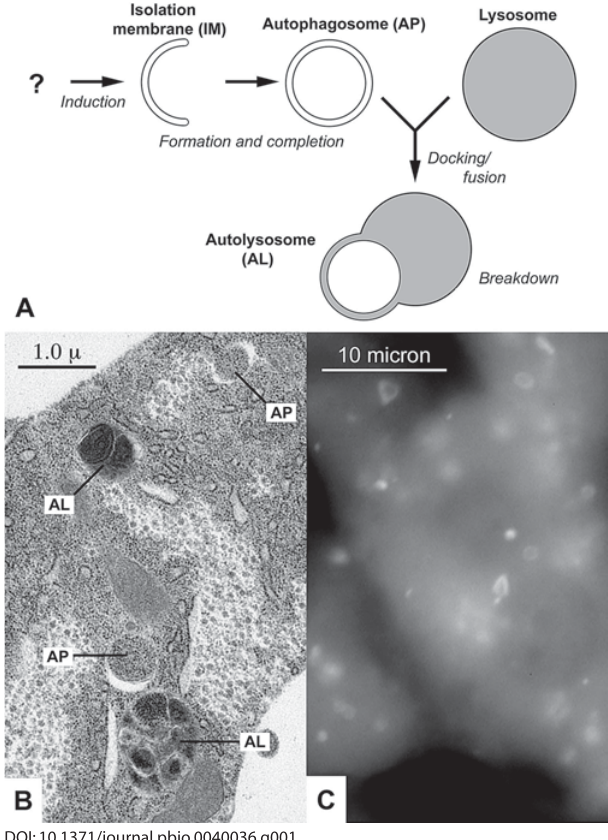
Figure 1. The Dynamic Membrane Events Involved in Autophagy (A) Upon induction of autophagy, a membrane sac called the isolation membrane (IM) forms and engulfs portions of the cytoplasm. Sealing of its edges gives rise to the double-membrane bound autophagosome. Fusion of the outer membrane with a lysosome results in formation of an autolysosome, in which the inner autophagosomal membrane and its contents are degraded. (B) Starvation-induced autophagosomes (AP) and autolysosomes (AL) in the fat body (the functional analogue of the liver) of a fruit fl y larva. Note that APs contain intact cytoplasm, whereas the contents of ALs show various stages of degradation. (C) Liver cells of starved mice carrying a fl uorescently tagged LC3 transgene, labeling cup-shaped and ring-shaped structures that correspond to IMs and autophagosomes, respectively. Images courtesy of Ryan Scott (B) and Dr. Noboru Mizushima